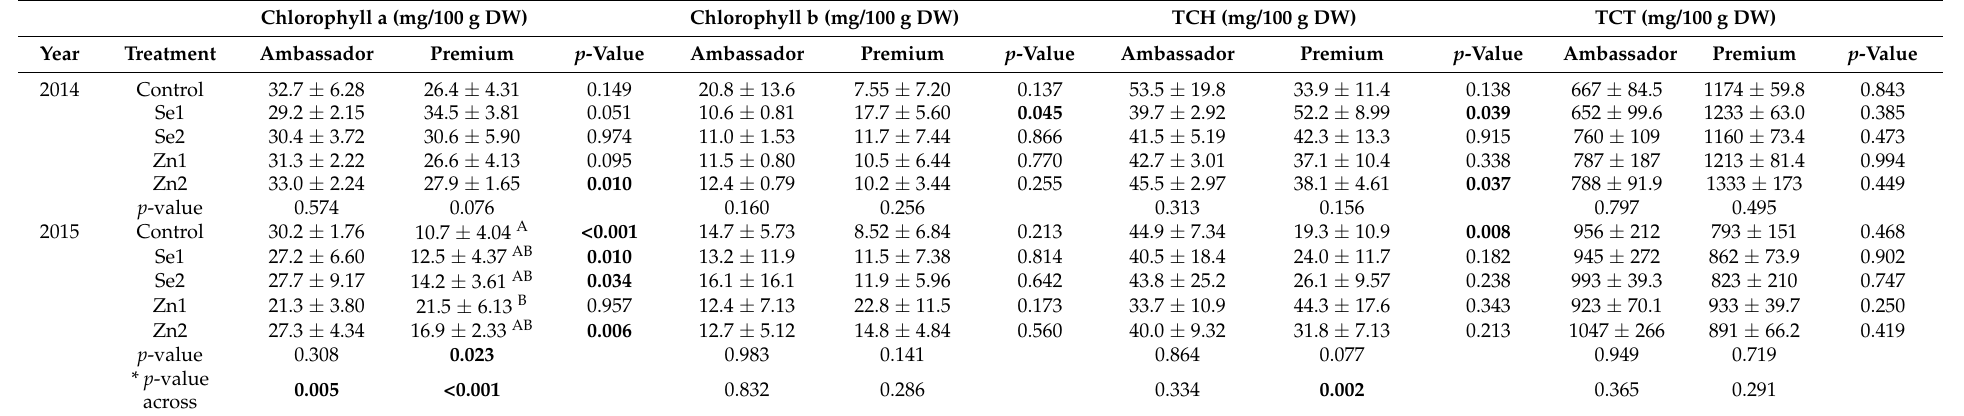
Table 3. Effect of foliar-applied Se and Zn, variety and year on seed chlorophyll a, chlorophyll b, total chlorophyll and total condensed tannin